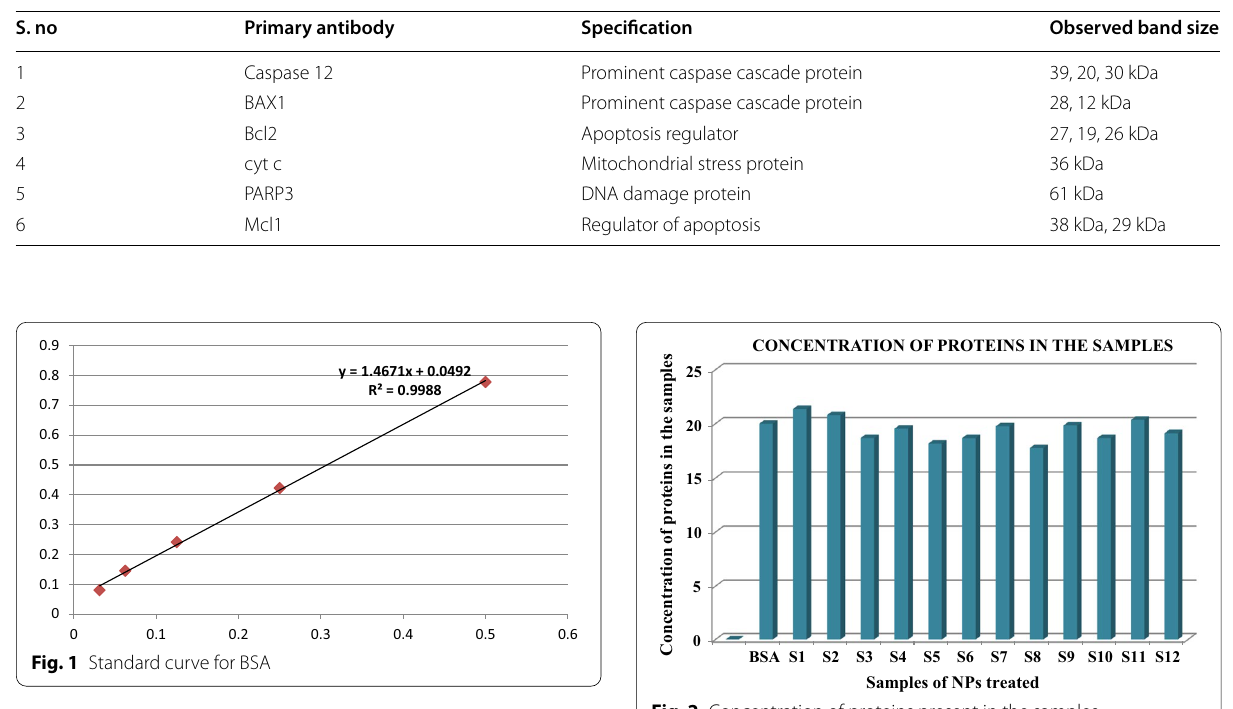
Table 1 The six apoptotic proteins under study